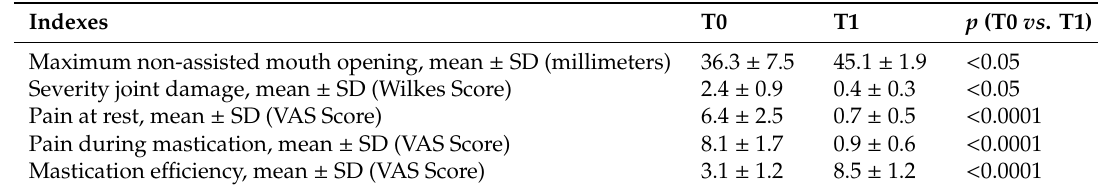
Table 2. Clinical data at follow-up.